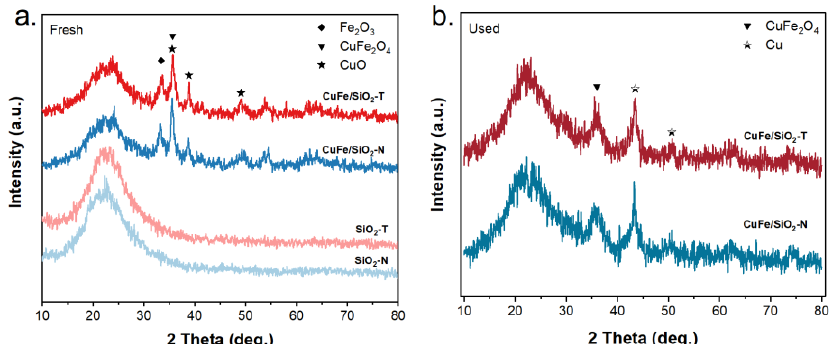
Figure 2. XRD patterns of the CuFe/SiO 2 samples: ( a ) fresh samples and ( b ) used samples.